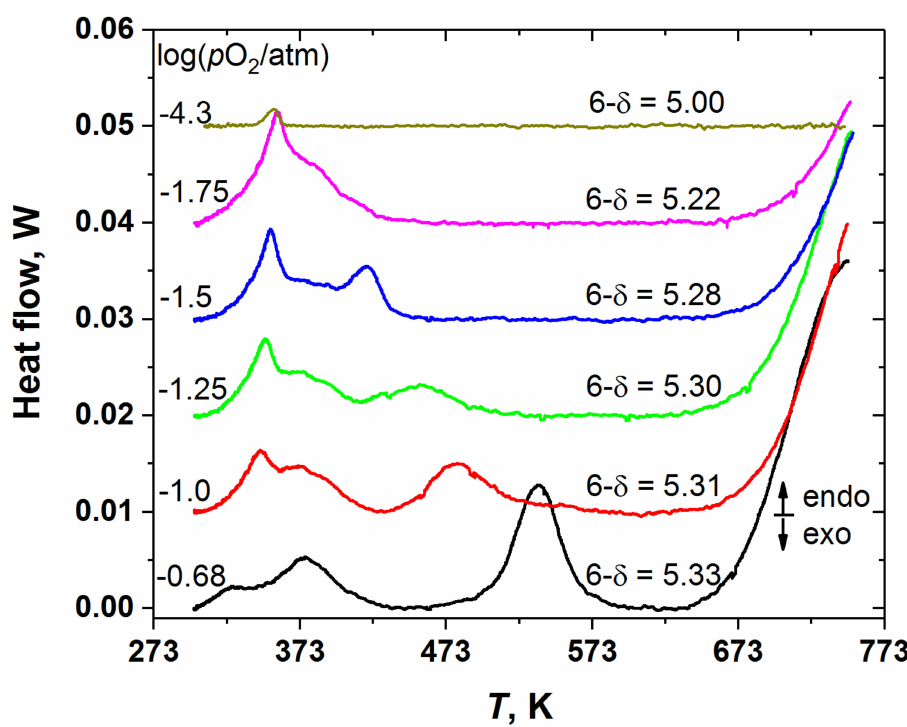
Figure 2. The DSC curves recorded at different p O 2 for the YBC samples with different initial oxygen nonstoichiometry. The curves are shifted relative to each other for the sake of convenience.